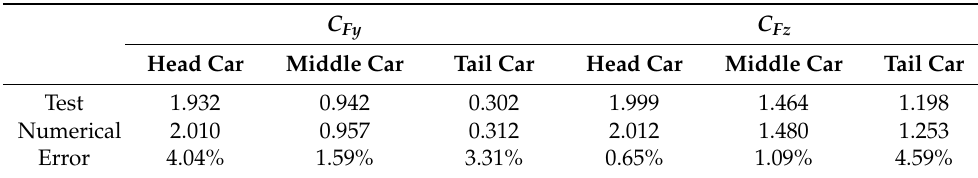
Table 2. Comparison of the side and lift force coefficients between the wind tunnel tests and simulations under a crosswind at a yaw angle of 19.8 ◦ . C Fy C Fz